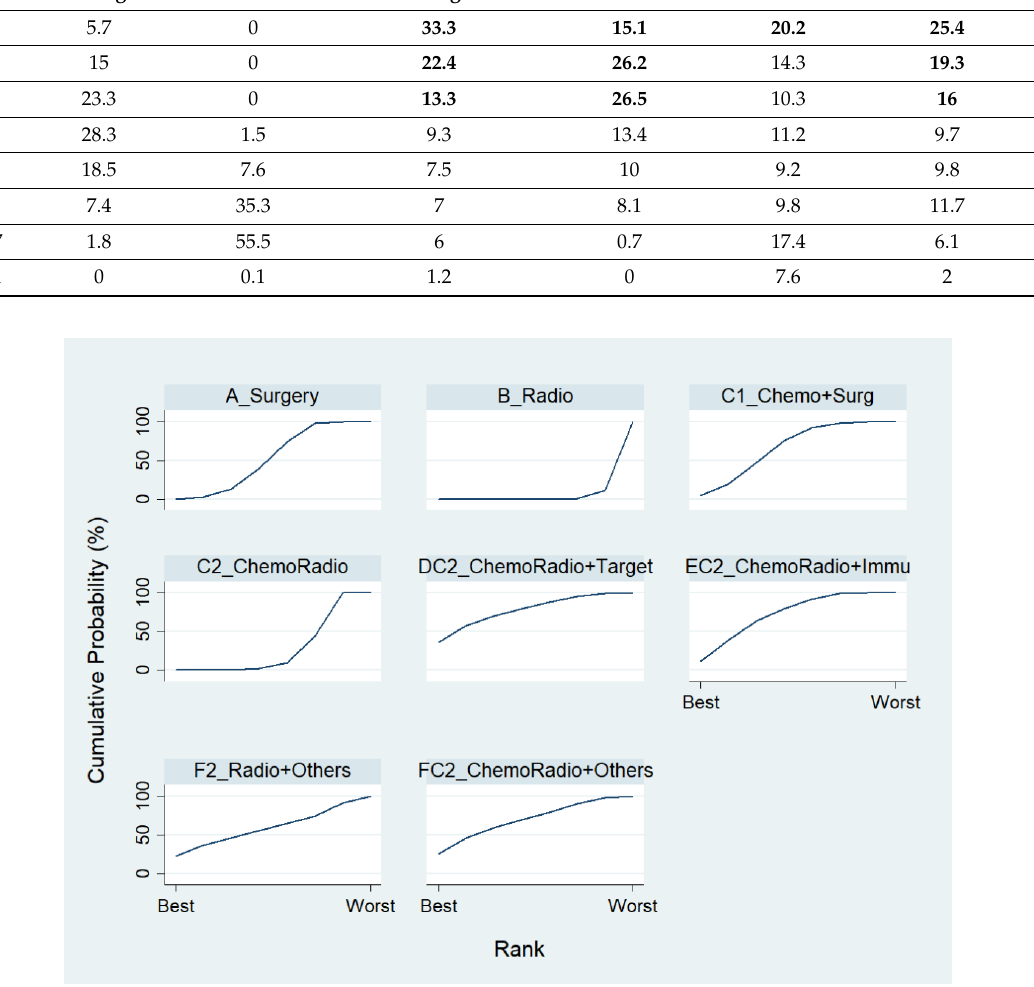
Figure 6. Rankogram for the non-advanced lung cancer in response rate.